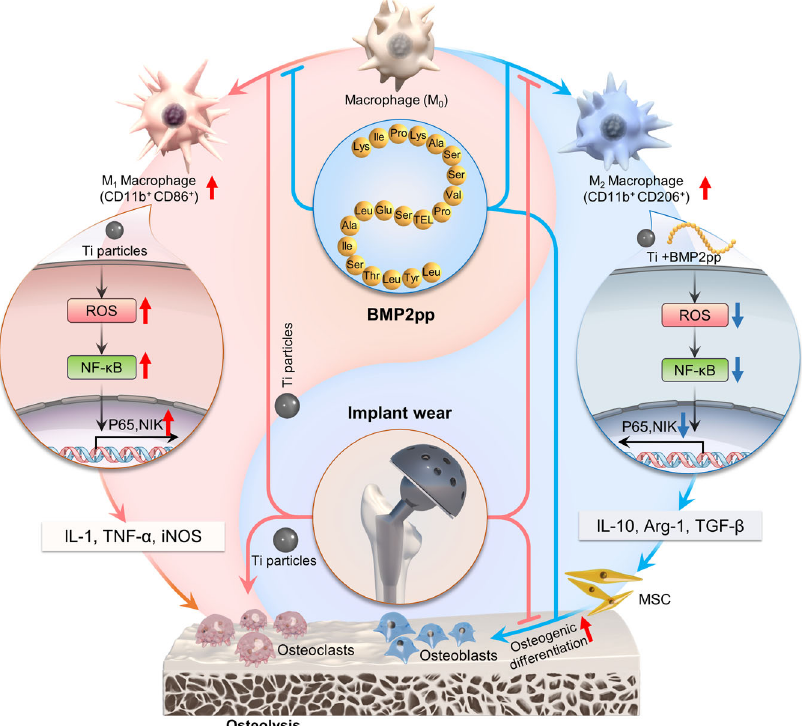
Fig. 8 Schematic illustrations of the dual effects of BMP2pp in Ti particles induced osteolysis. In addition to directly promoting the osteogenic differentiation, BMP2pp also can inhibit the polarization of M1 macrophage caused by Ti particles, and promote the polarization of macrophages to M2 type, which secret related factors to reduce the enhanced oxidative stress in the microenvironment by Ti. Thus, BMP2pp could alleviate Ti-induced osteolysis. This image does not contain any third-party material or previously-created